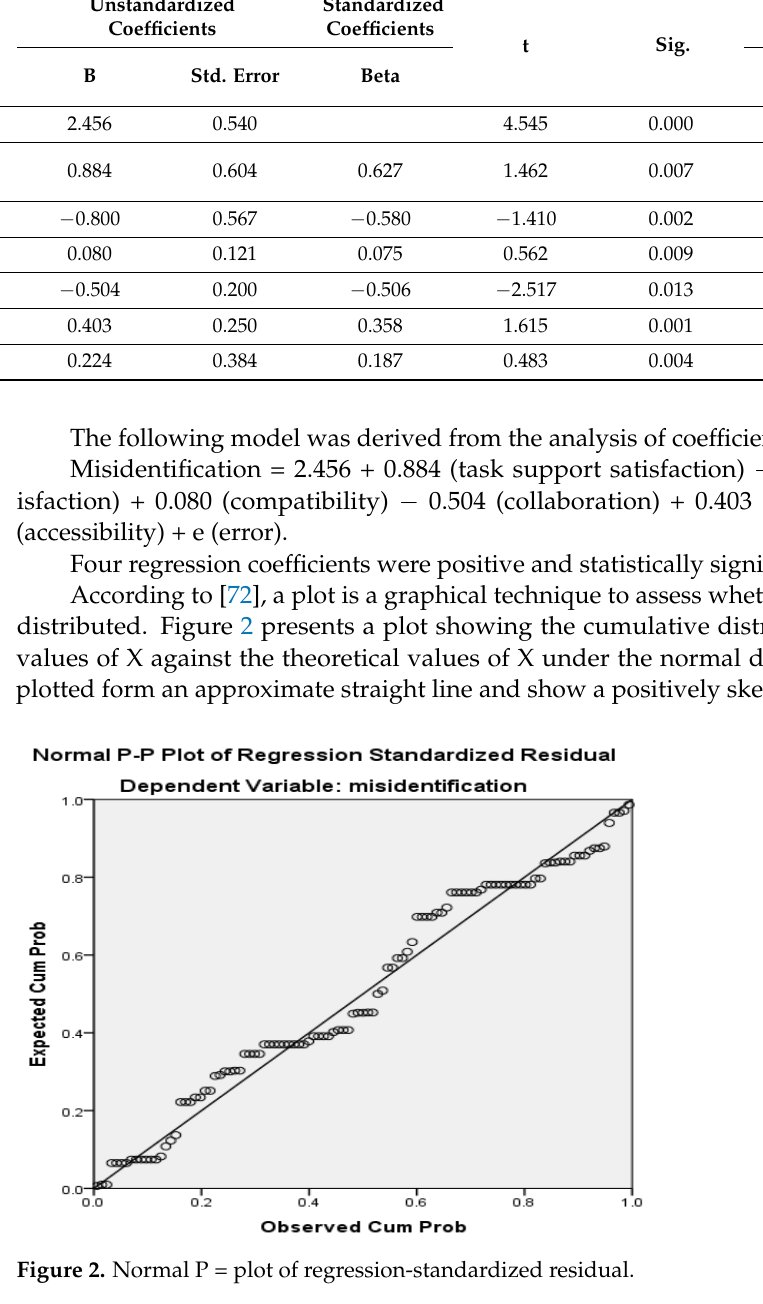
Table 13. Coefficients for the HIS.